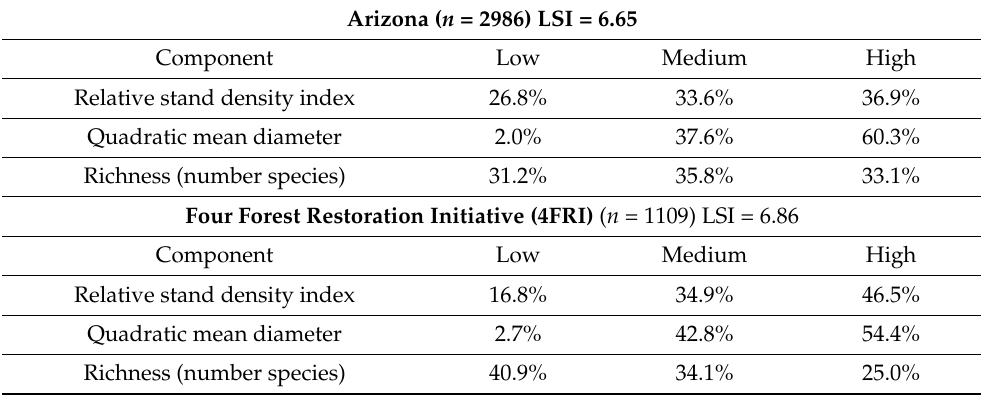
Table 5. Example of the scalability and the comparability of LSI the state of Arizona, the Four Forest Restoration Initiative (4FRI), and each of the National Forests within 4FRI. The of the landscape area for each of the three components was calculated utilizing the Forest Inventory Analysis (FIA) Database with the number of plots noted; the percentages may not add up to zero because of non-stocked stands. The LSI was calculated from the percentages and ranges from 3 to